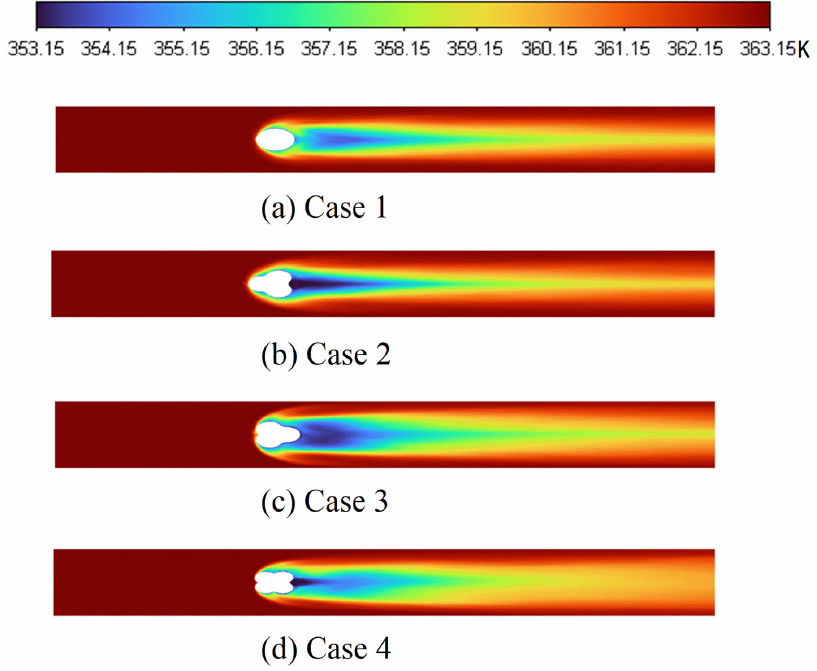
Figure 6. Comparison of wall time-averaged temperature distribution contour maps.